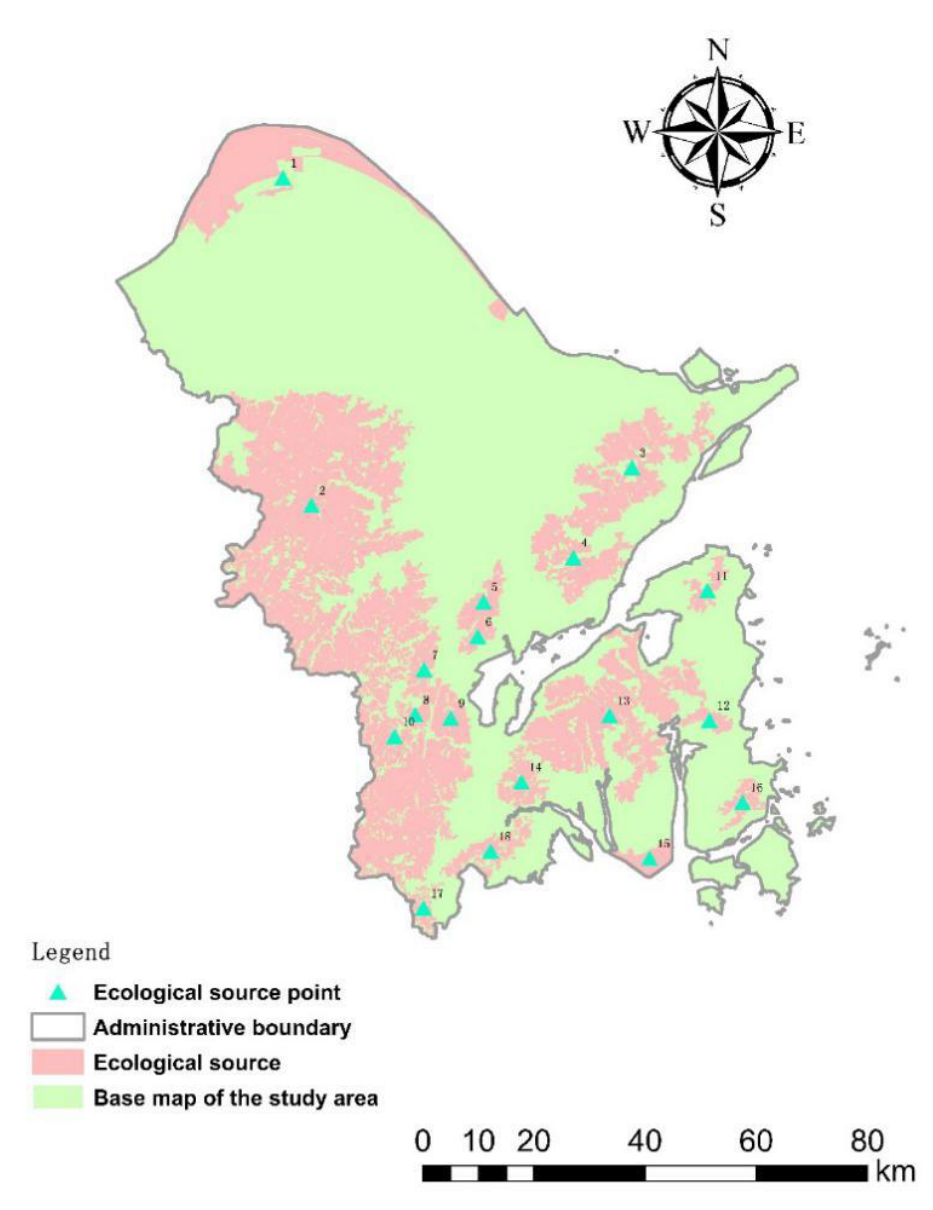
Figure 3. Ecological Fig. 3. Ecological source.